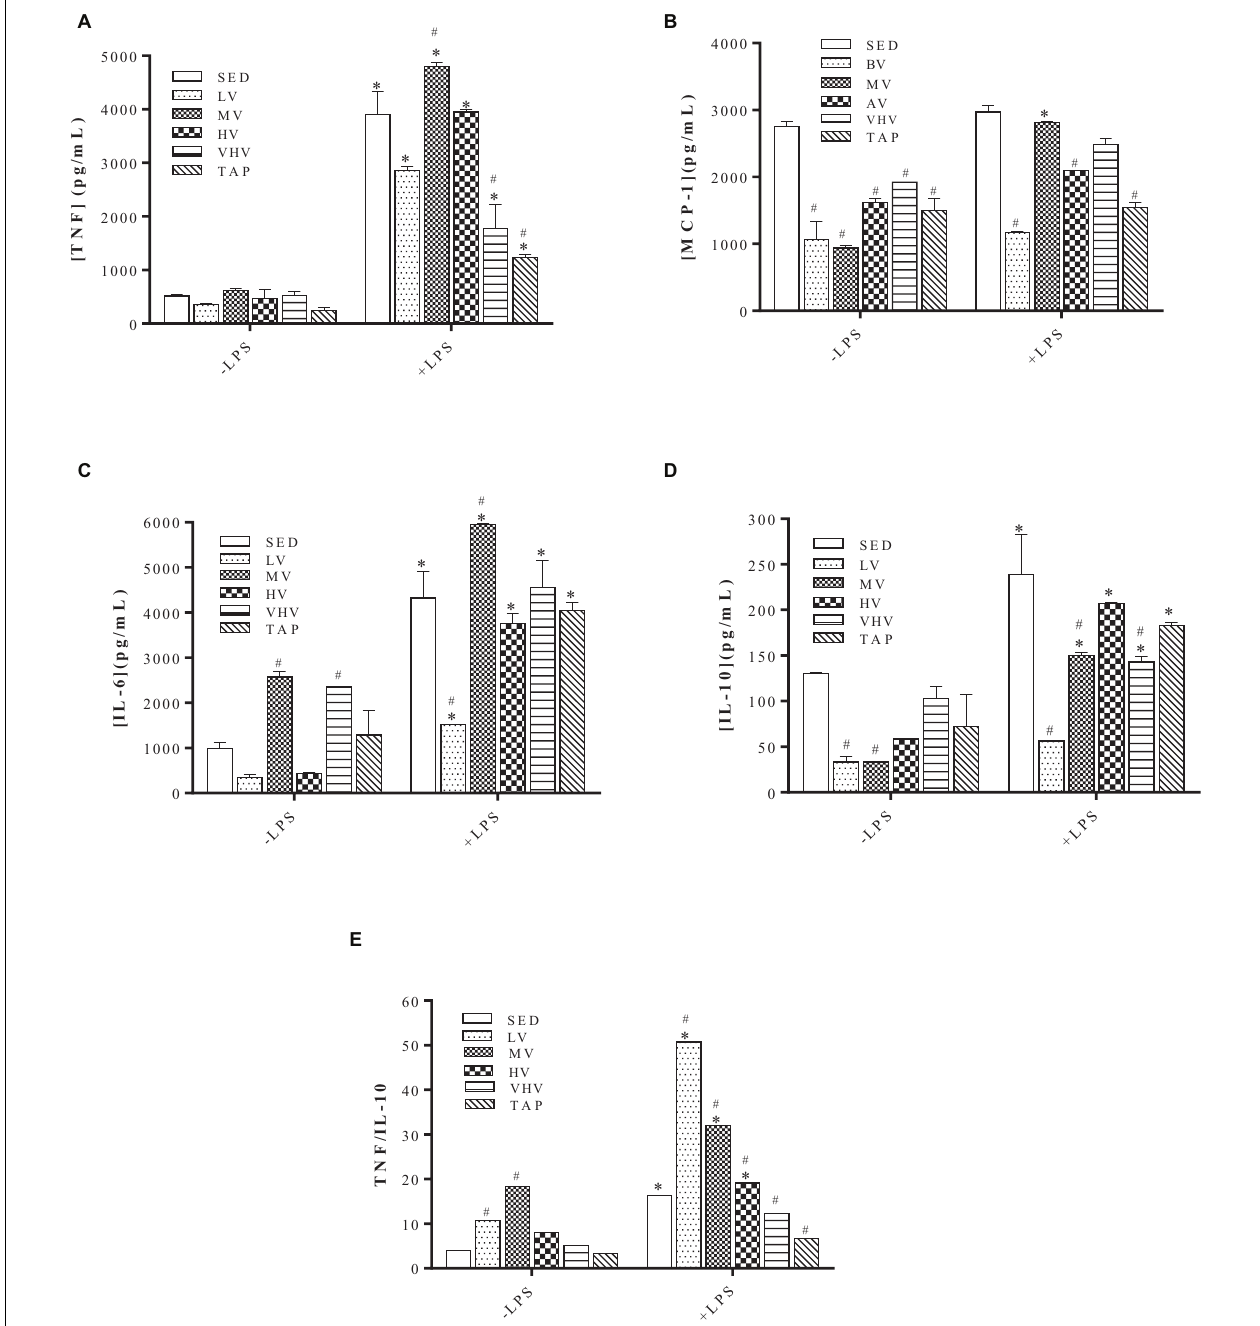
FIGURE 3 | Effect of physical training on cytokine production by Leishmania major -infected macrophages. Macrophages were extracted from the mice peritoneum, plated in the absence or presence of bacterial lipopolysaccharide (LPS) 1 µ g/ml for a period of 24 h, and then infected with L. major (five parasites:one macrophage), for an equal period of 24 h. Values represent the mean and standard error of two experiments with at least six animals per group. ∗ P < 0.05 relative to their respective untreated control with LPS. # P < 0.05 in relation to their respective SED controls. Groups: sedentary control (SED), low volume (LV), medium volume (MV), high volume (HV), very high volume (VHV), and tapering (TAP). (A) TNF, (B) MCP-1, (C) IL-6, (D) IL-10, and (E) TNF/IL-10 ratio.